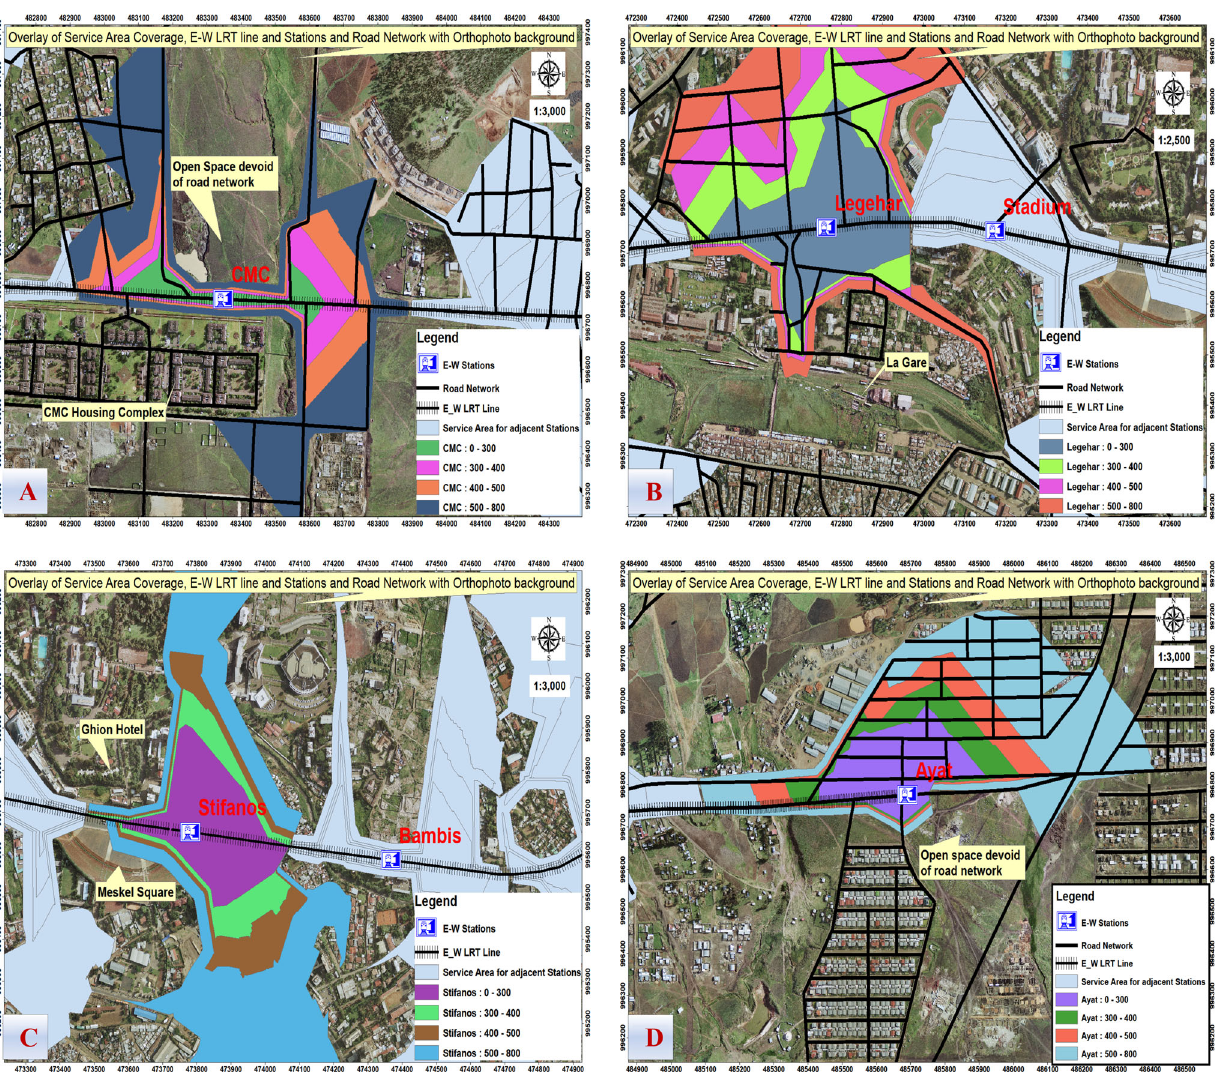
Fig. 6 Service areas of stations a CMC, b Legehar, c Stifanos, d